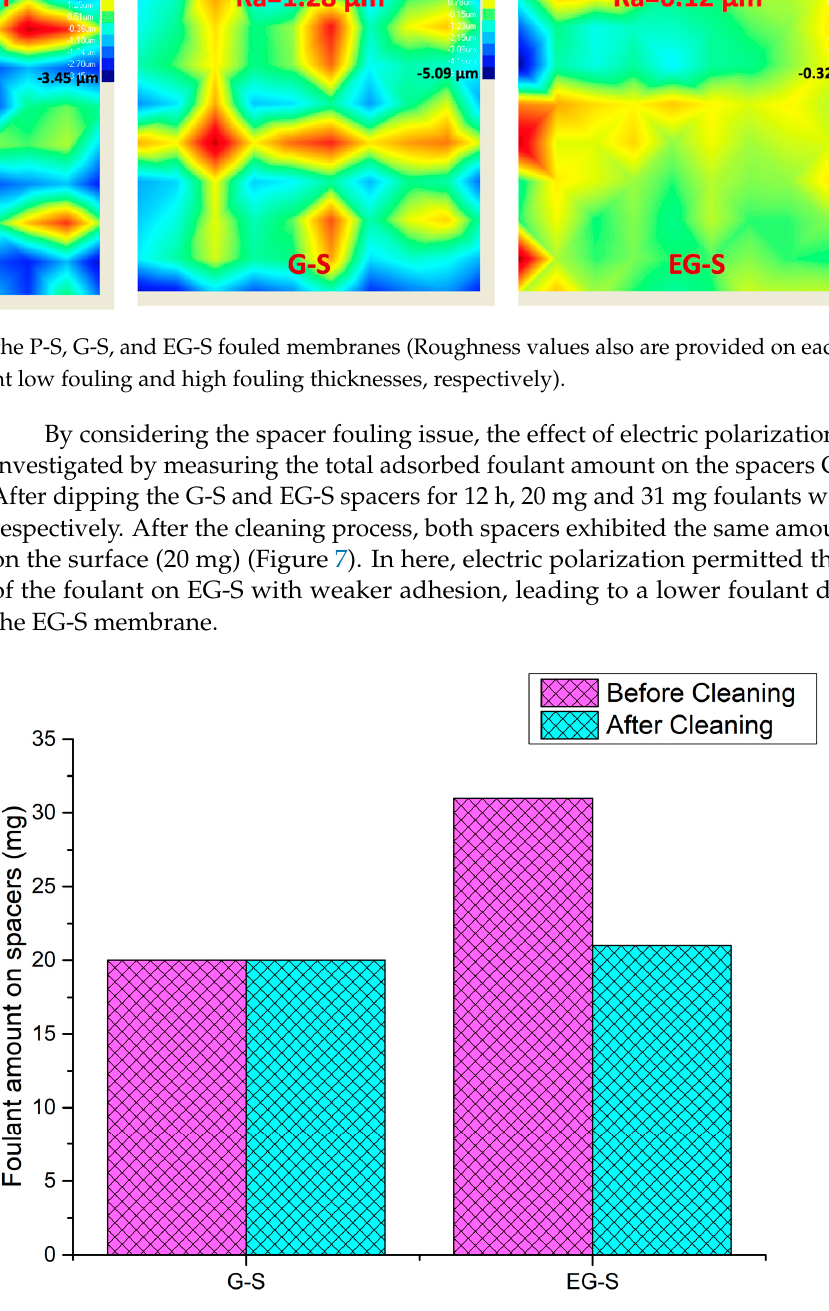
Figure 5. Average foulant volume for the fouled membranes with the P-S, G-S, and EG-S spacers.